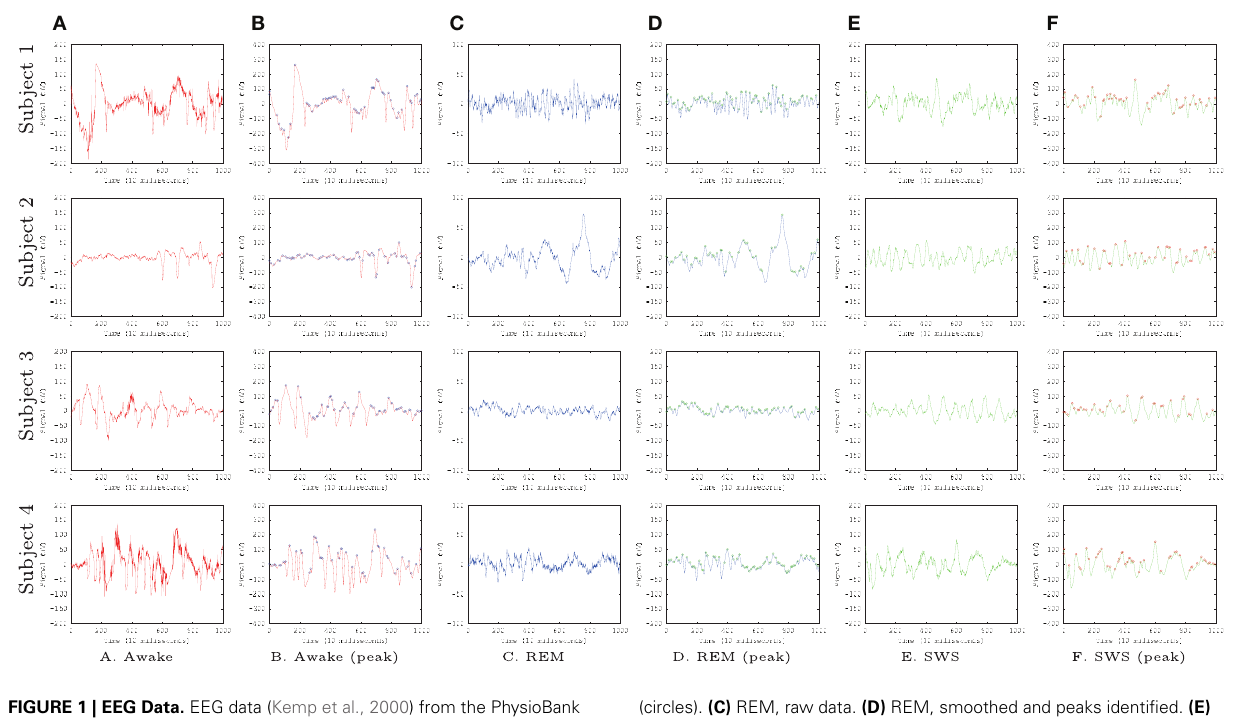
FIGURE 1 | EEG Data. EEG data (Kemp et al., 2000) from the PhysioBank (Goldberger et al., 2000) are shown. Each row represents data from each subject (four total) and each column represents different states. (A) Awake, raw data. (B) Awake, smoothed (Gaussian filter, σ = 1), and peaks identified